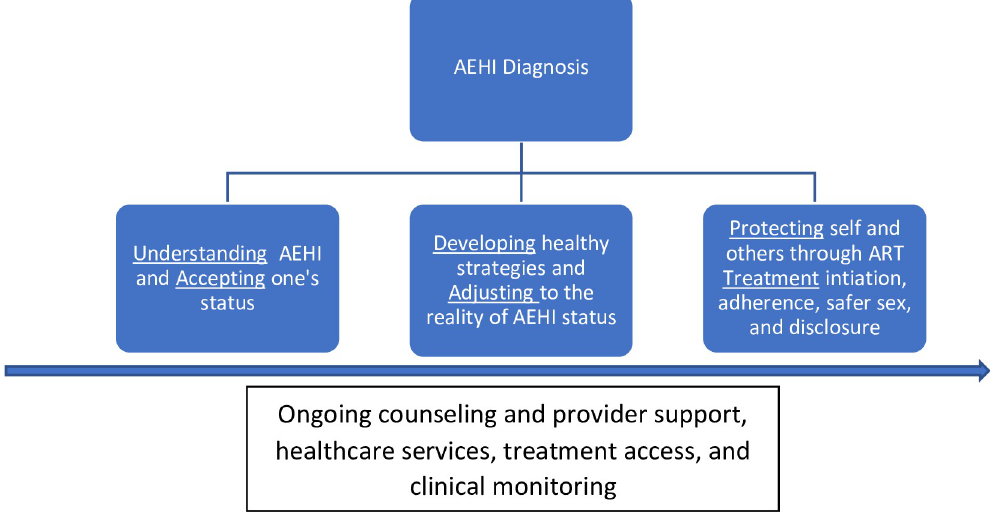
Fig 1. Conceptual model: Adjustment to acute and early HIV (AEHI) diagnosis, ART initiation, and sexual risk reduction (van der Elst et al. 2019) [14].